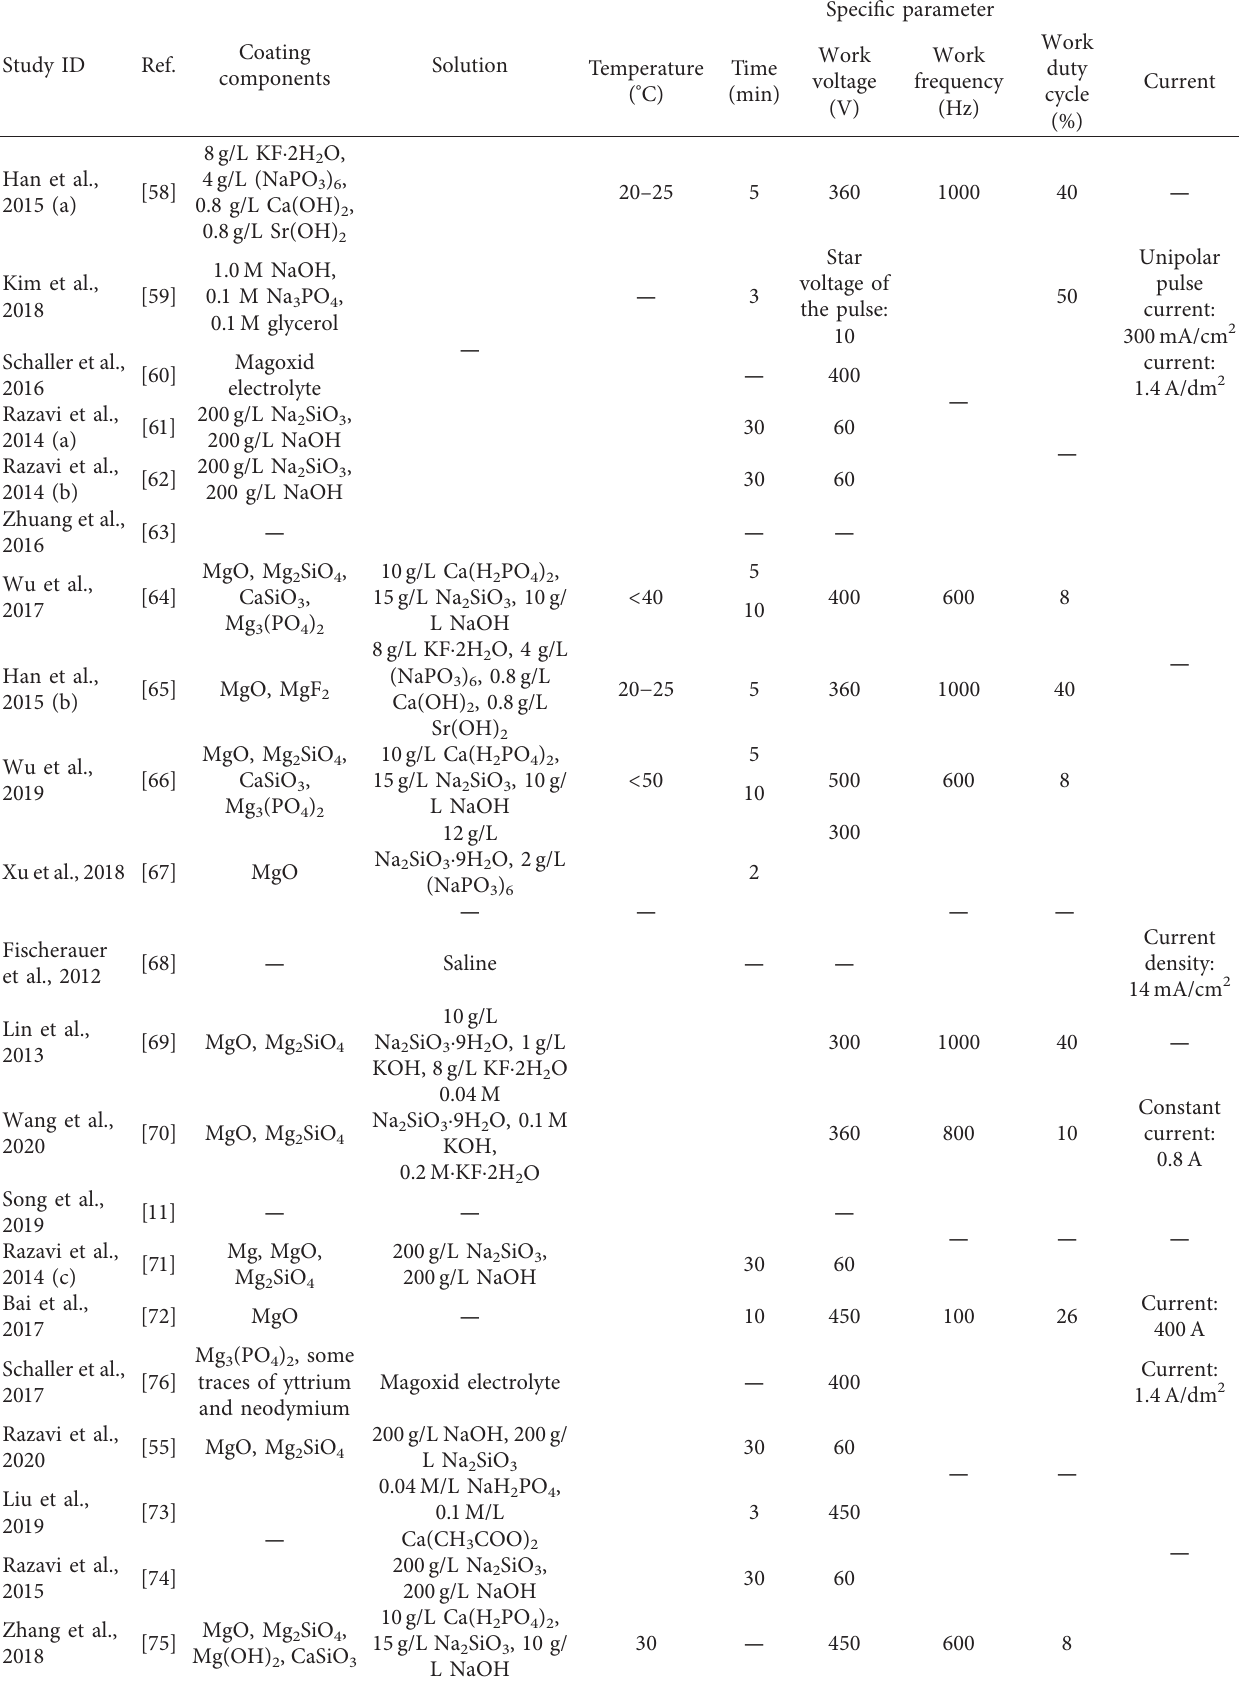
Table 4: Processing parameters of MAO